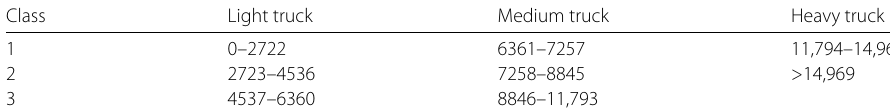
Table 2 Live load. Weights (Kg) of three different classes of trucks